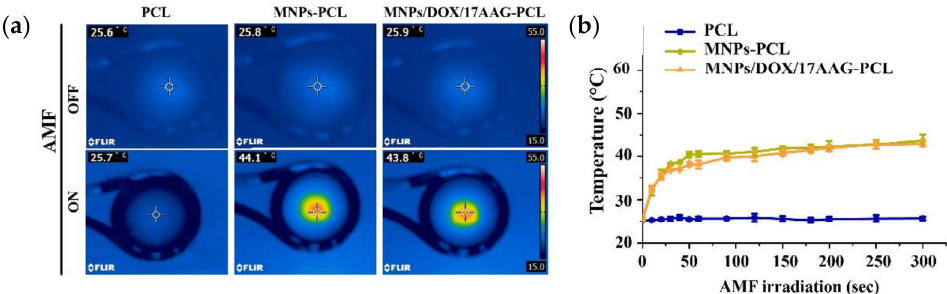
Figure 11. ( a ) PCL ‐ based nanofibers’ mesh infrared thermal imaging; ( b ) PCL ‐ based nanofibers’ mesh with different contents during AMF irradiation at different times. Reprinted/adapted with permission from Ref. [77]. 2021, International Journal of Molecular Sciences.